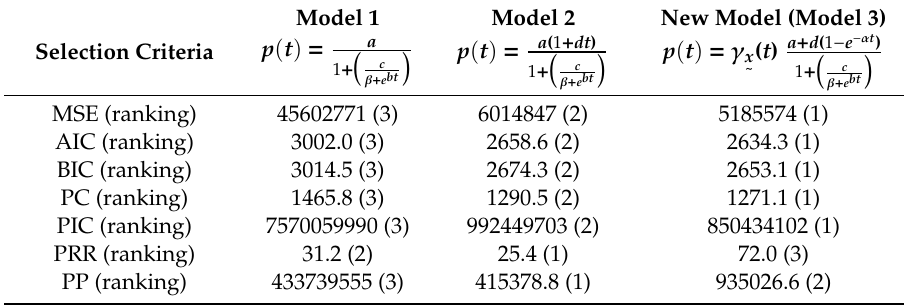
Table 2. Model comparison and ranking results using the model selection criteria based on the available data for the United